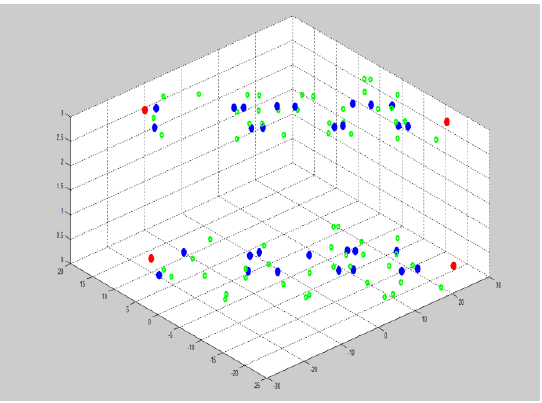
Figure 3. Surveying control points as dual nodes: doors are represented as blue points, elevators as red points while room and corridor control points as green points.